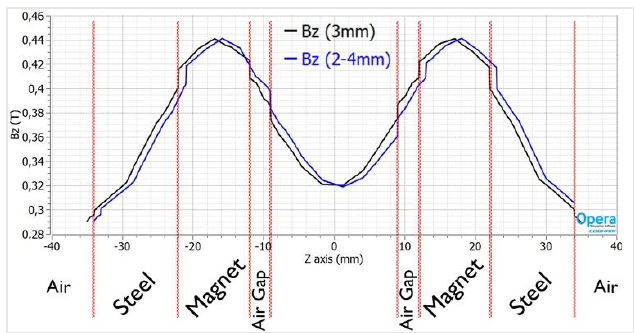
Figure 15. Normal component of the magnetic density across the axial length of the machine with 3 mm air gaps compared with the 2–4 mm air gaps machine.